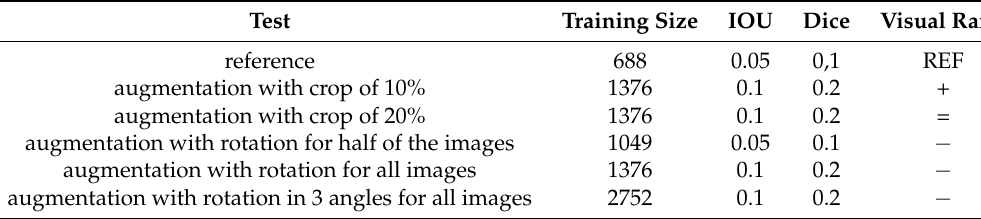
Table 3. Effect of the augmentation of object-based tiles on segmentation results. Test Training Size IOU Dice Visual Rank reference 688 augmentation with crop of 10% augmentation with crop of 20% augmentation with rotation for half of the images 1049 augmentation with rotation for all images augmentation with rotation in 3 angles for all images